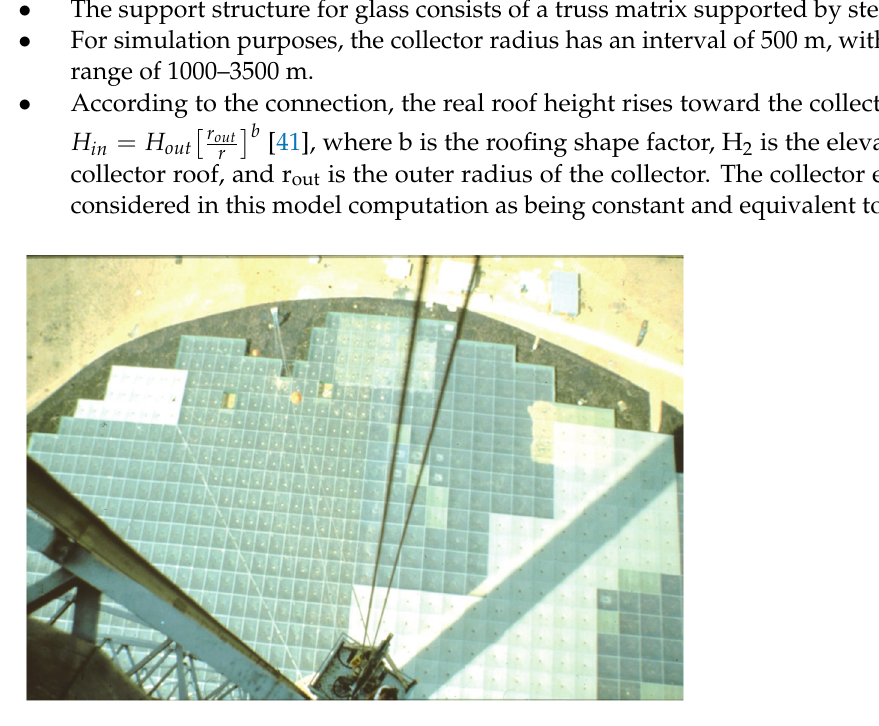
Table 3. Selected dimensions, limits, and intervals for model simulation. Dimension